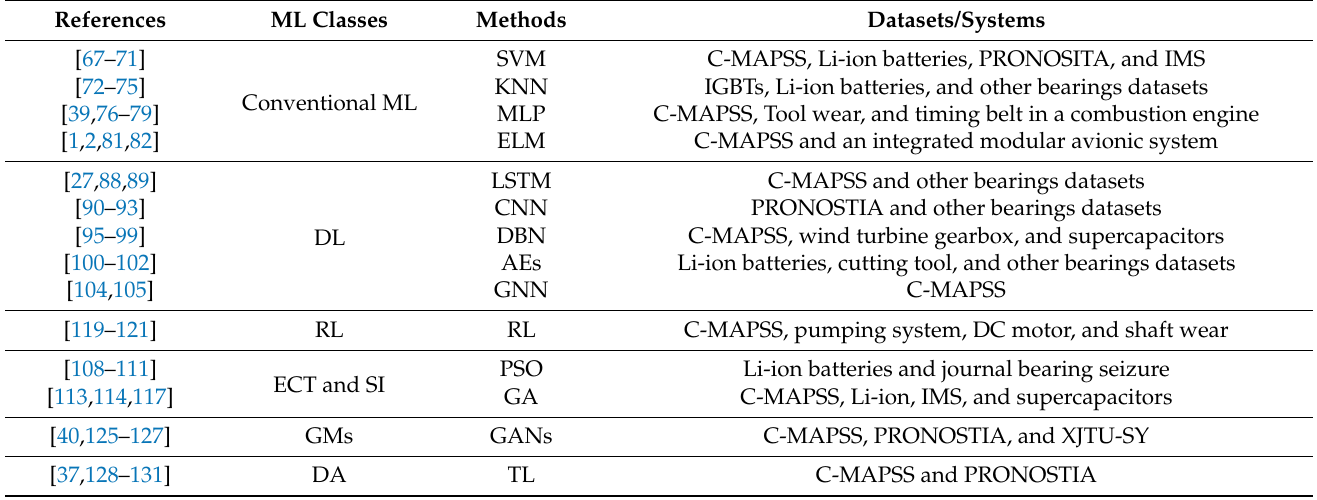
Table 4. Summary of the most important used ML tools in RUL